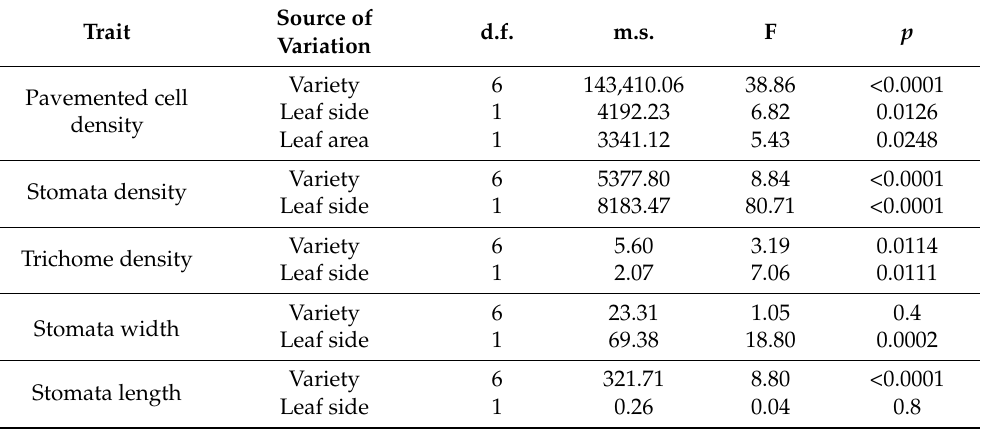
Table 1. Univariate ANOVA of cell densities and sizes of leaf epidermis of the wild Capsicum annuum var. glabriusculum and six cultivated varieties of Mexican C. annum . The sample size for cell density counts was 25 plants, and for cell size measurements, it was 19 plants. p < 0.05 indicates significant